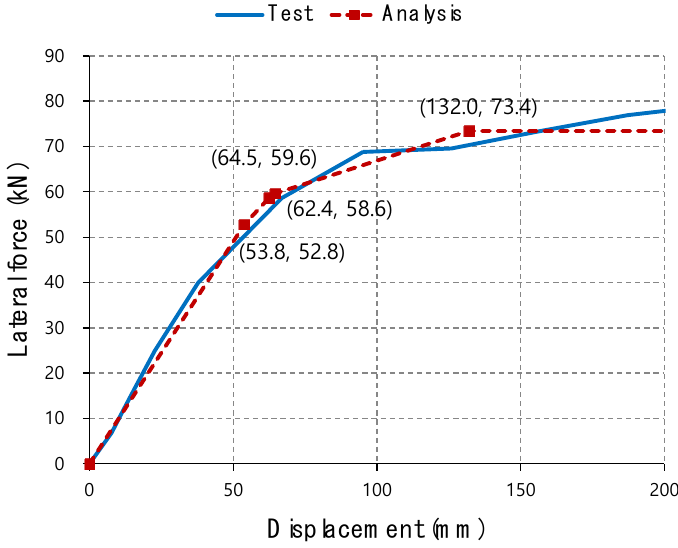
Figure 26. Validation of the analysis model for IC_OB_B specimen.